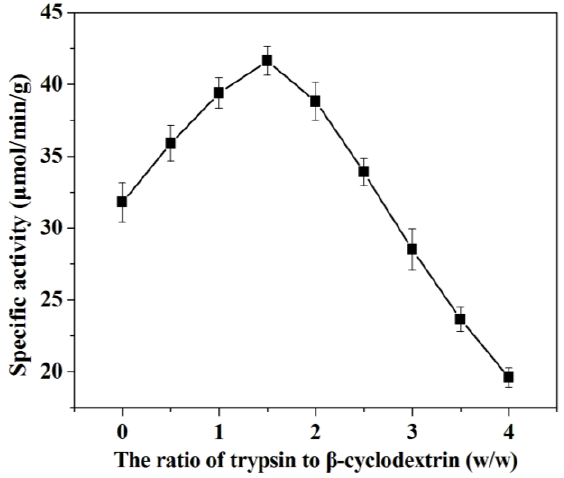
Figure 4. Effect of the ratio of trypsin to β-cyclodextrin on the specific activity of immobilized